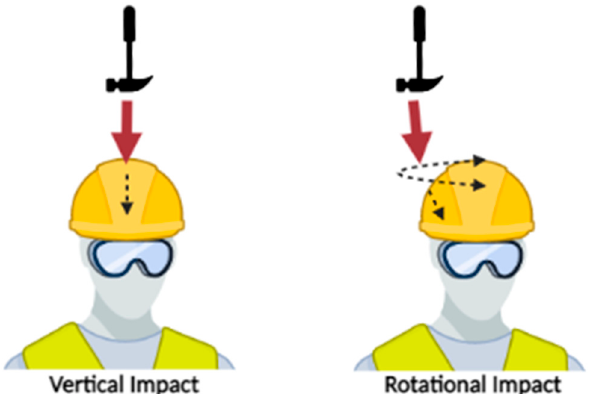
Figure 1. Industrial safety helmets have a suspension design that prevents injury from vertical impact. These helmets are not designed to prevent injury from side or rotational impacts that would increase injury severity and diffuse axonal injury.